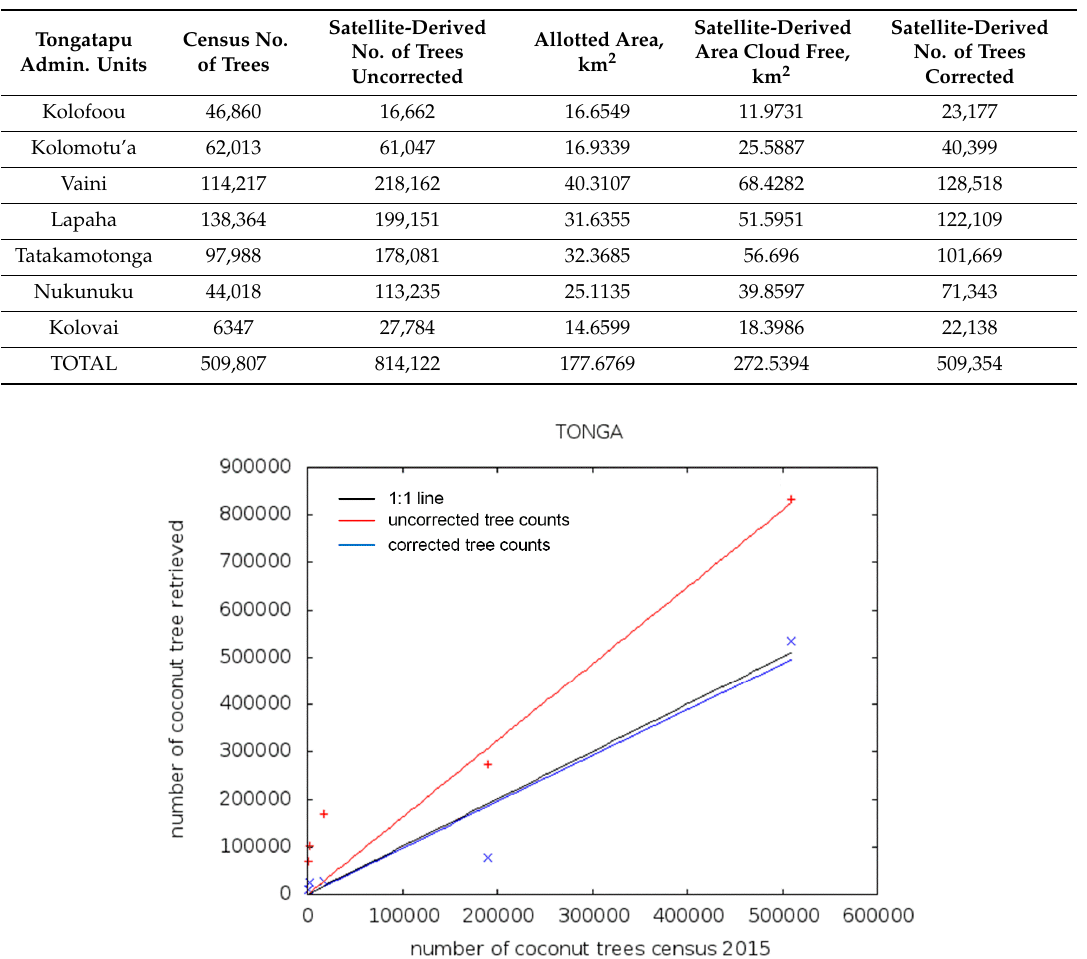
Figure 8. Comparison of the algorithm tree counts over Tonga with the original 2015 agricultural census data (uncorrected tree counts) and accounting for the allotted land area (corrected tree counts). The black line is y = x.